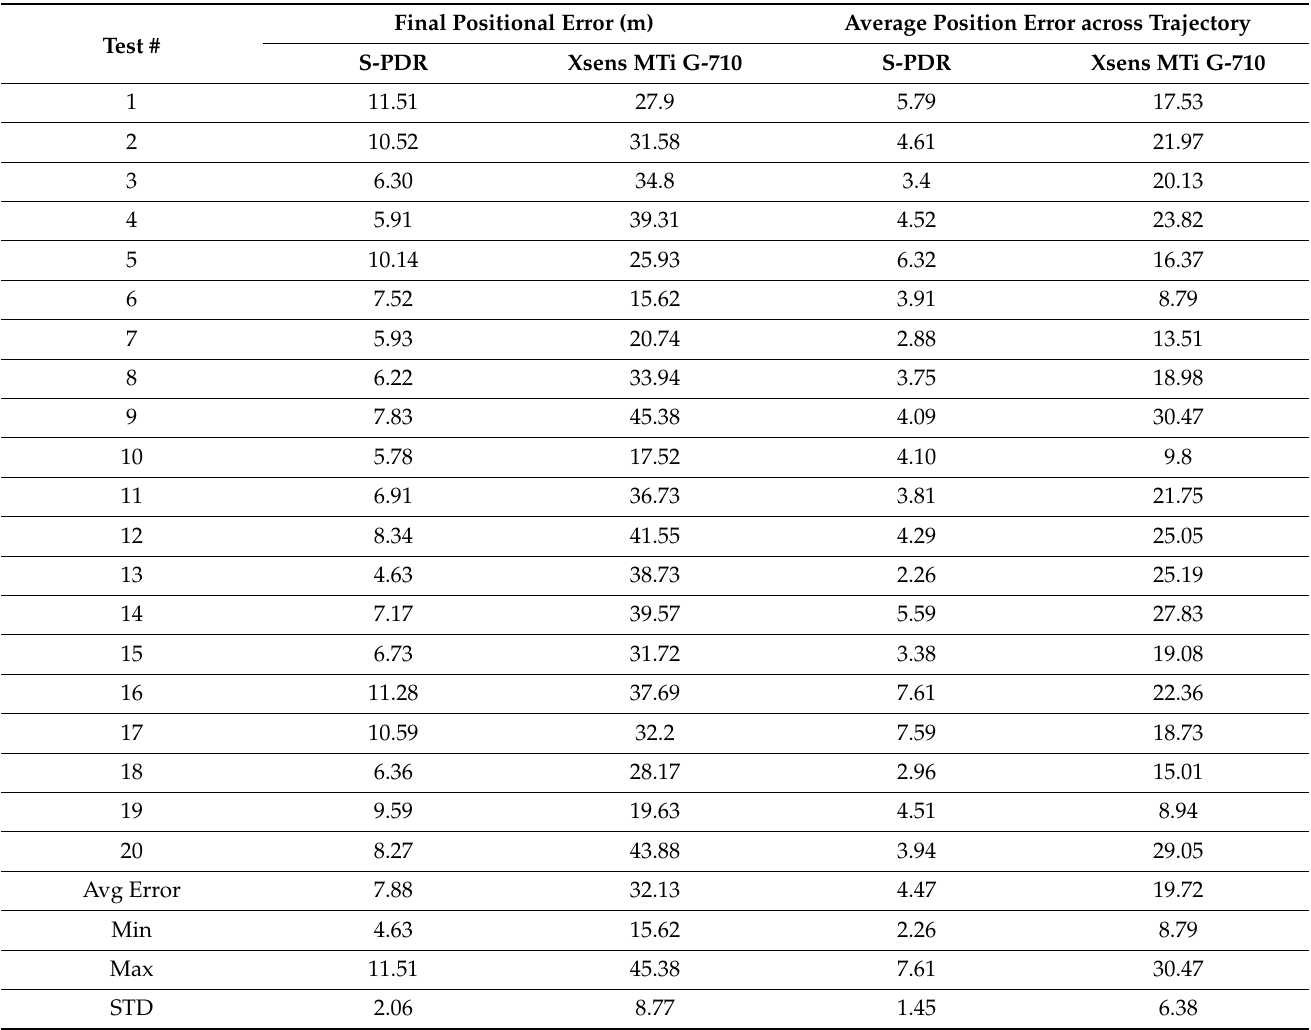
Table 2. Test results for indoor ENG building